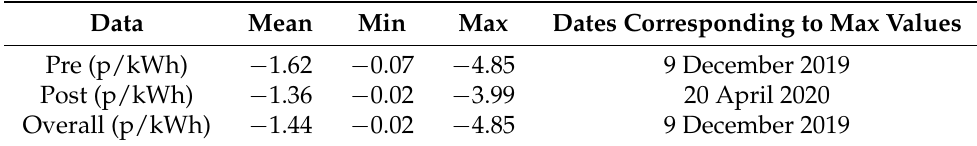
Table 3. Analysis of negative pricing in the agile tariff using the data from